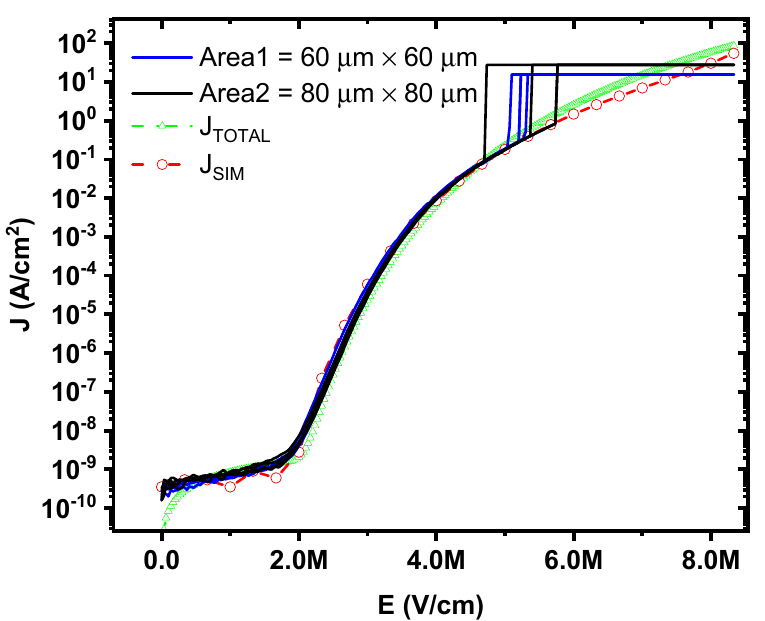
Figure 8. Comparison of measurement data, total model, and numerical simulations for current density versus the electric field.